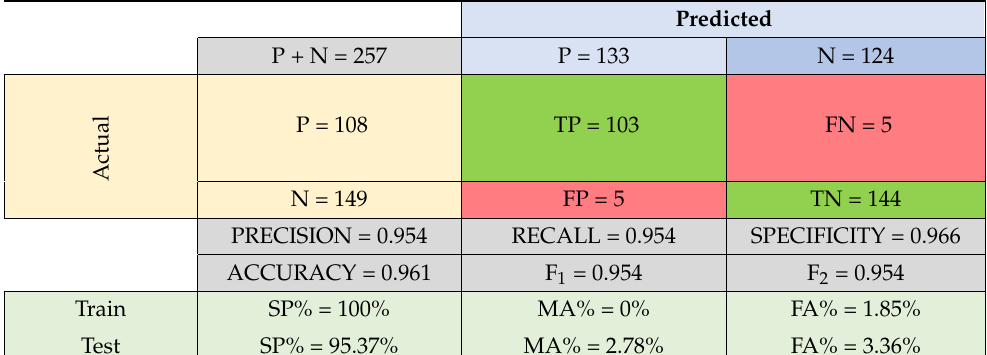
Table 4. Confusion matrix and performance indices of the MLP-NN prediction model evaluated on the test set.